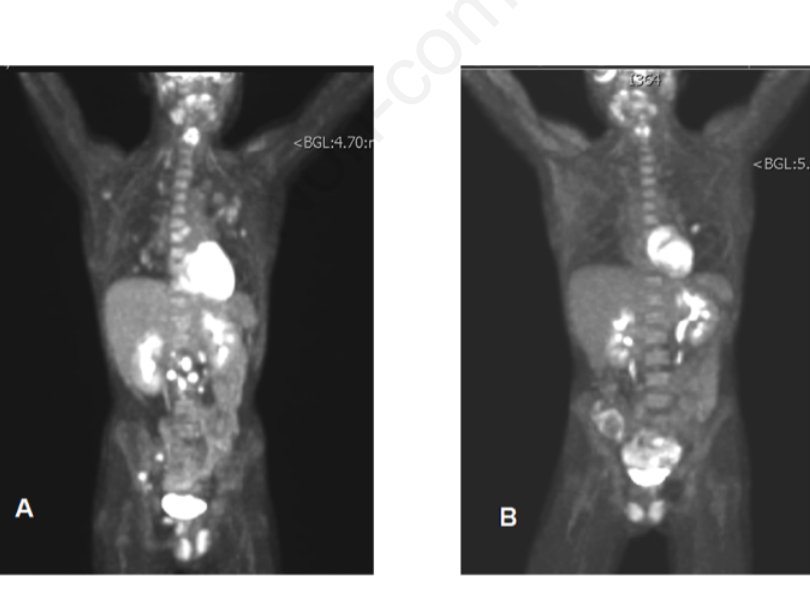
Figure 2. PET/CT scan during the second course of Nivolumab administration. A) Six months after Nivolumab discontinuation the PET/CT showed disease recurrence in the lungs, axillary and retroperitoneal lymph nodes. B) After 8 cycles of Nivolumab re- administration, mCR was documented according to PET/CT criteria. PET/CT: Positron emission tomography/computed tomography, mCR: metabolic complete